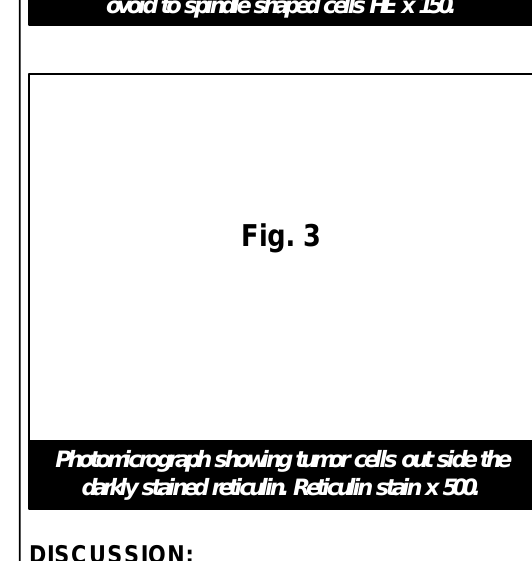
Photomicrograph showing tumor cells out side the darkly stained reticulin. Reticulin stain x 500.